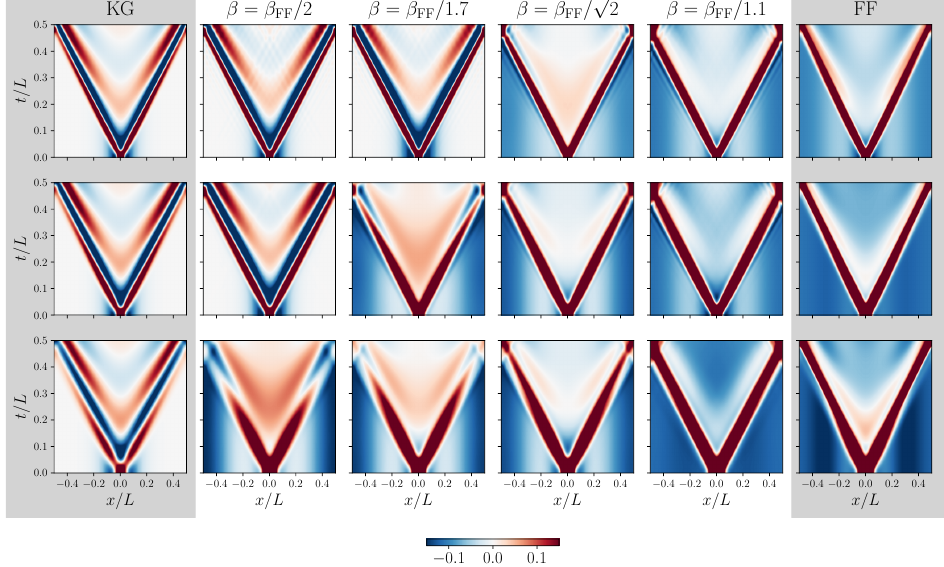
Figure A.1: Transition from free boson-like to free fermion-like behaviour after a local quantum quench in the sine–Gordon model: Density plots of the time ϕ ( x , t ) / ( 2 π ) as a function of the space evolution of the soliton density ρ ( x , t ) = β∂ x and time coordinates x , t at various values of the parameters. From left to right the (cid:112) = sine–Gordon coupling β changes from 0 (Klein–Gordon limit) to β 4 π (free FF fermion point), while from top to bottom the initial external field bump changes from shorter and thinner to taller and wider bumps (the three rows correspond to / m σ taking the bump height parameter A β and the Gaussian width parameter m FF 1 1 the values ( 12,1 / 3 ) , ( 15,4 / 9 ) and ( 18,2 / 3 ) , respectively). Note the change in the propagation fronts from having oscillatory tails (Klein–Gordon dynamics) to fast de- caying tails (free fermion dynamics). Note also that the background is neutral in the free boson limit, while at the free fermion point a negatively charged background appears to compensate for the positive bump charge. This change is triggered by a crossover transition in the initial state, which occurs at an intermediate value of β which depends on the initial bump strength. Compared to Fig. 1.1 of the main text, = 24,26,28 and the results shown here were extrapolated using data with cut-offs e c